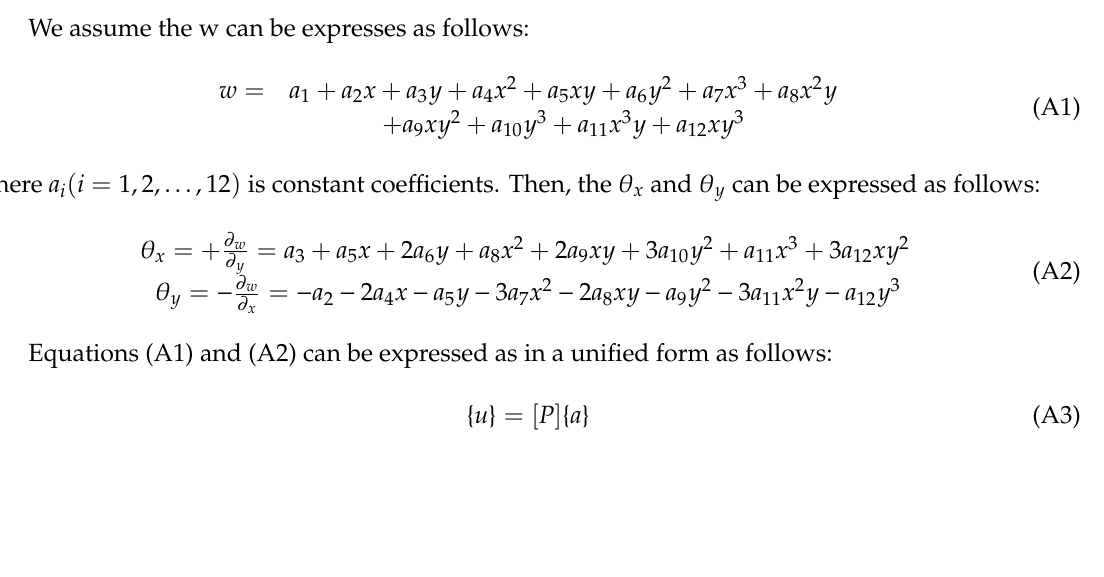
Figure A1. The quadrilateral element and the definition of degrees of freedom for the